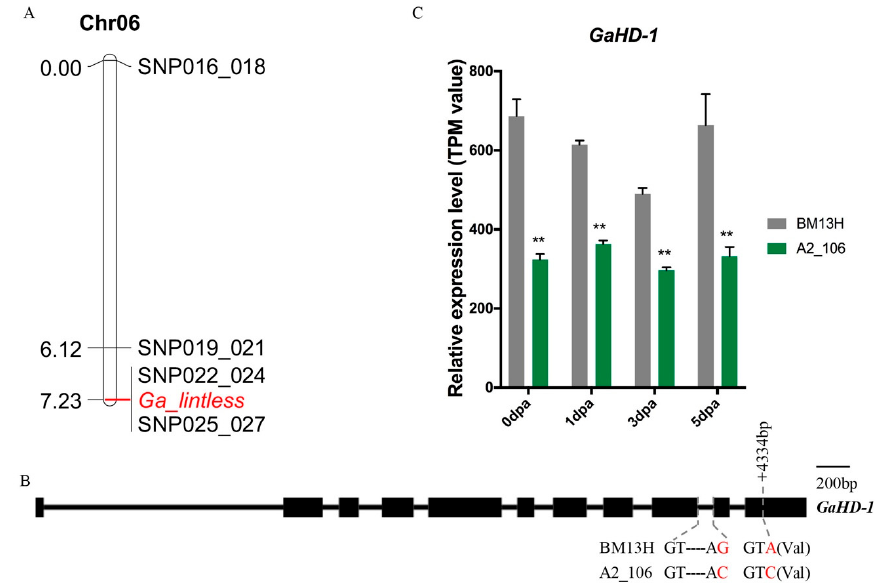
Figure 3. Genetic mapping of Ga_lintless and comparison of sequence and expression level of Ga_HD-1 between A2_106 and BM13H. ( A ) Genetic linkage map of Ga_lintless on Chr06 with distances marked in centimorgans, and ( B ) gene structure and sequence variations of Ga_HD-1 between BM13H and A2_106. Exons are indicated by the black boxes. Variation in nucleotide sequences between the two accessions are indicated in red font. ( C ) Relative expression level of GaHD-1 in A2_106 and BM13H. Values are in transcripts per million mapped reads. ** indicates the differences relative to BM13H were significant, with a probability of 0.01.